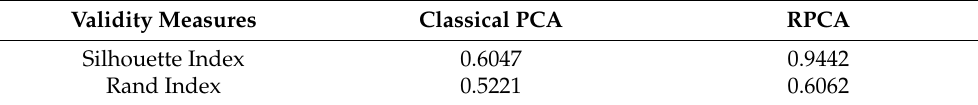
Table 5. Indices to measure the quality of clustering results for torrential rainfall